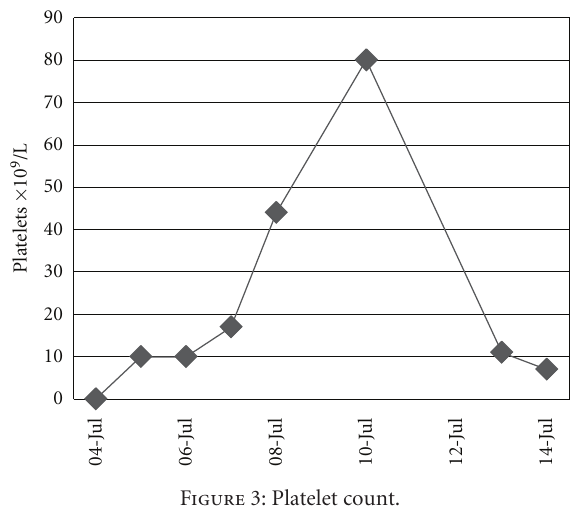
Figure 3: Platelet